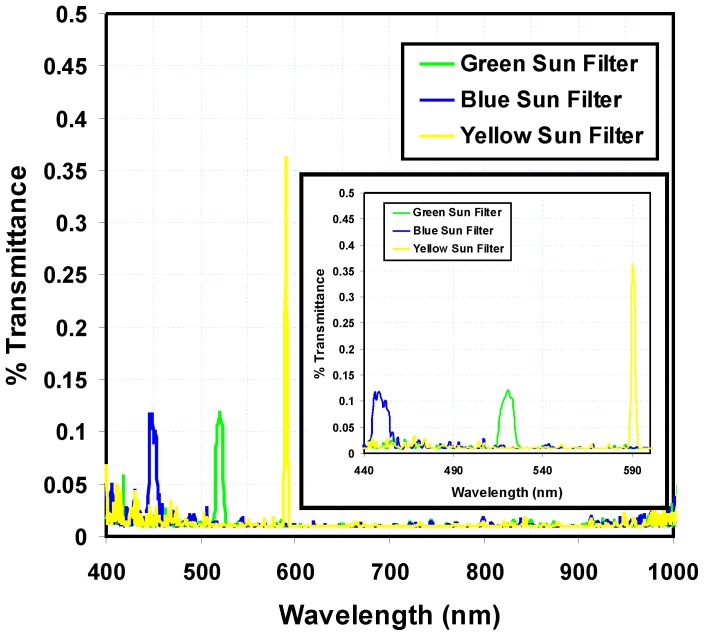
Plot of % Transmittance vs. wavelength for the 3 sun filters used in this study.Neutral density filters were used to attenuate the light to <1% of original value to provide “on-scale” measurements.